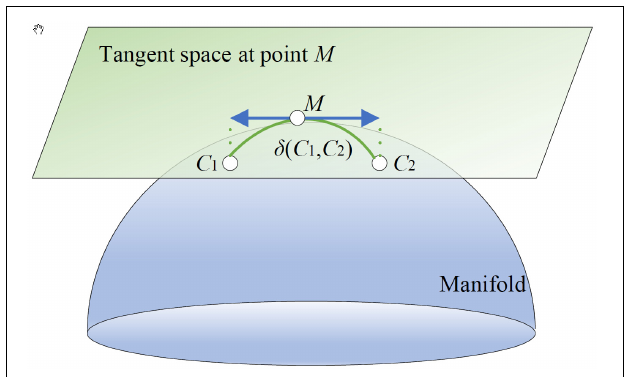
FIGURE 2 | A Riemannian manifold and its tangent space.